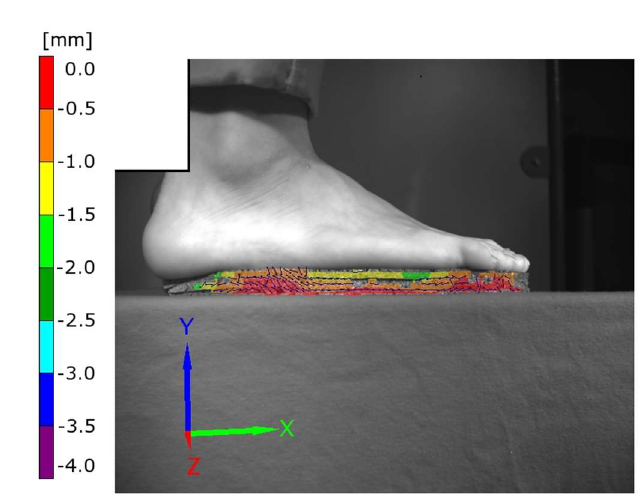
Figure 4. Measured strain for the EVA16 material at a gait frequency of 60 beats/min.